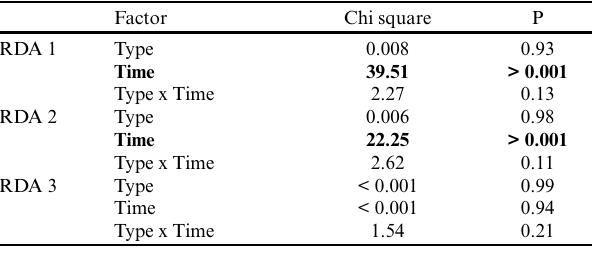
Table 3 . Results of linear mixed models showing main effects of lake type (“Type”; Reference lakes vs limed lakes) and period of study (“Time”; 1990–2019) and their interactions for dominant temporal scales (RDA 1–3) in the time series models. Note: no contrasts were made for subordinate scales (RDA 4 and RDA 5), present only in limed lakes, resulting in an unbalanced design (see Table 1). Significant factors are highlighted in